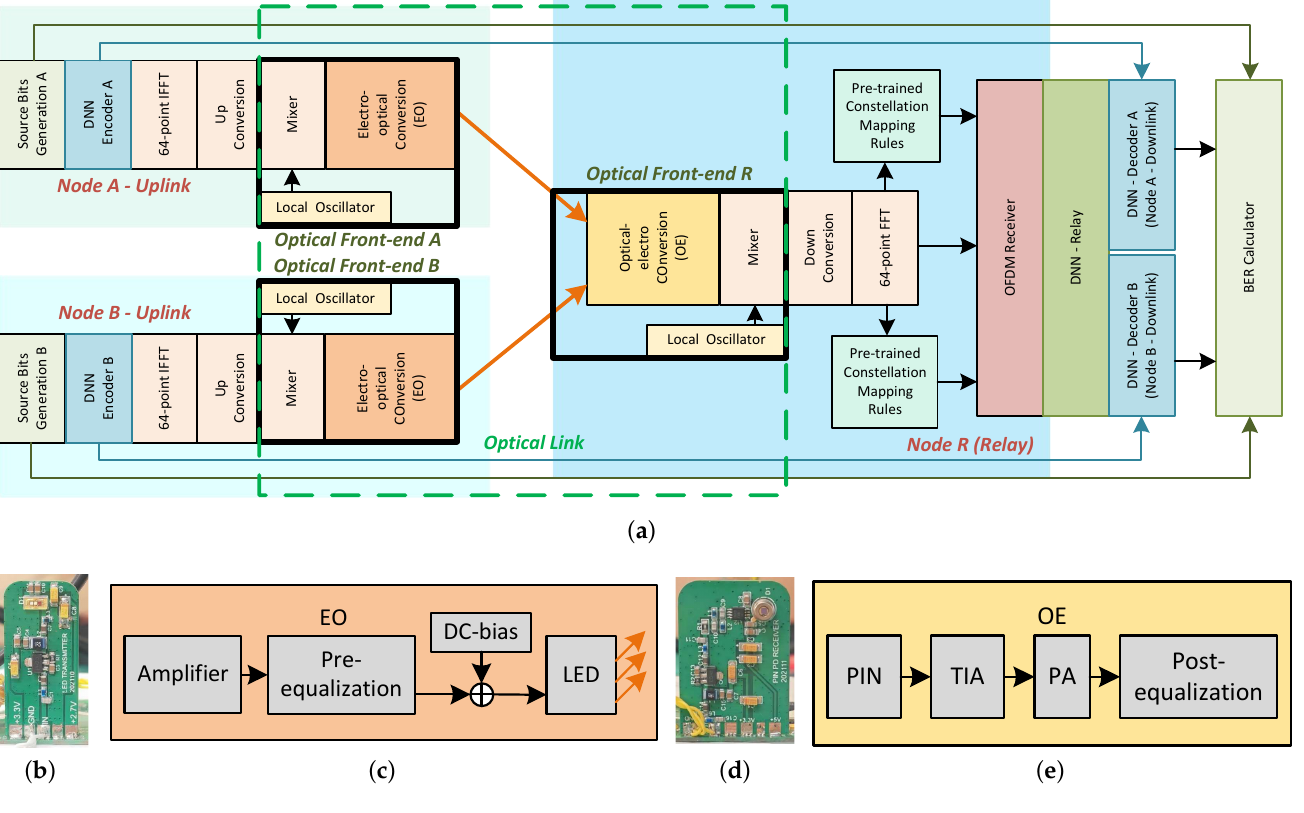
Figure 4. DP-VLC system design. ( a ) The whole system of DP-VLC; ( b ) electro-optical conver- sion component and ( c ) its circuit diagram; ( d ) optical-electro conversion component and ( e ) its circuit